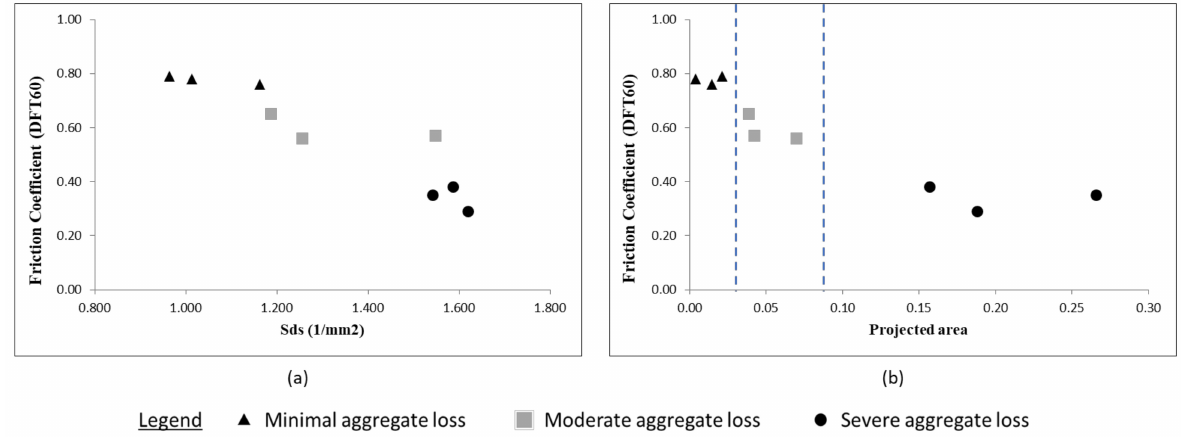
Figure 16. Relationship between DFT60 friction coefficient and parameters related to the aggregate distribution including ( a ) density ( S ds ) and ( b ) projected area.